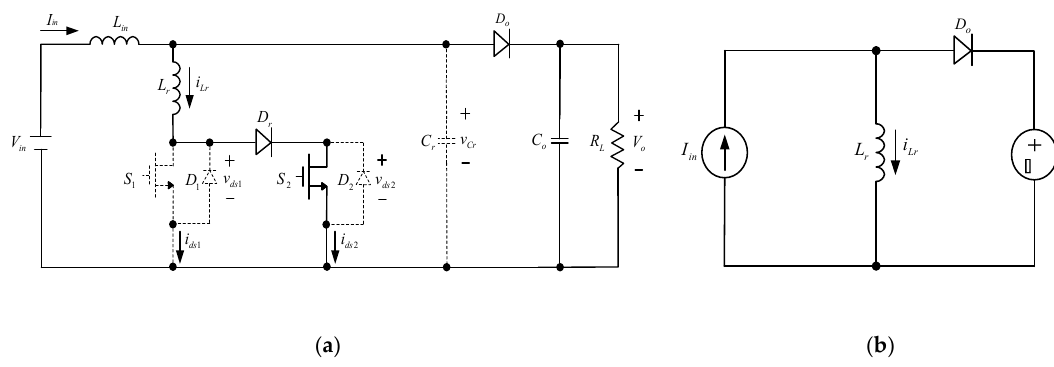
Figure 4. ( a ) Current flow in state 1; ( b ) Equivalent circuit of ( a ).